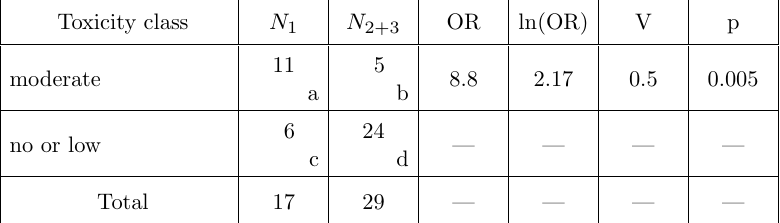
Table 7. Odds ratios (OR) for the forth partial criterion under